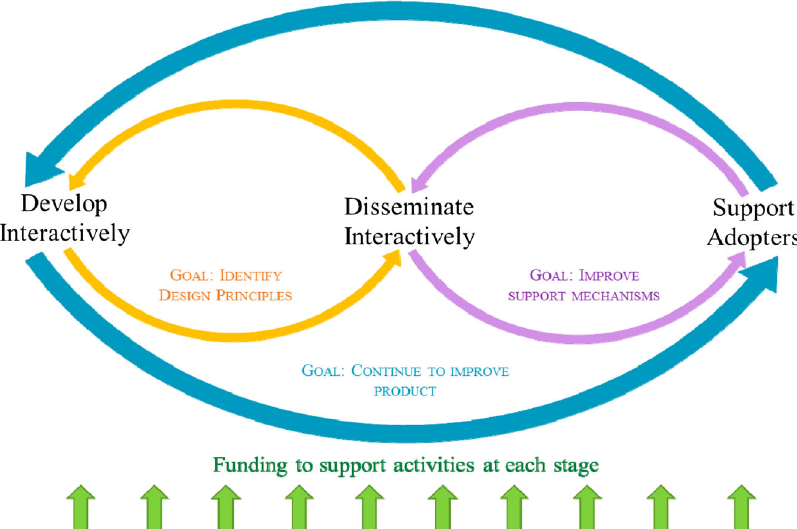
FIG. 5. Tentative model of designing for successful propagation resulting from phases 1 and 2 of this study. The model has three core propagation activities to be undertaken by the project team: interactive development, interactive dissemination, and support of adopters. The model emphasizes both the roles of three feedback loops that interconnect different stages and the role of funding for